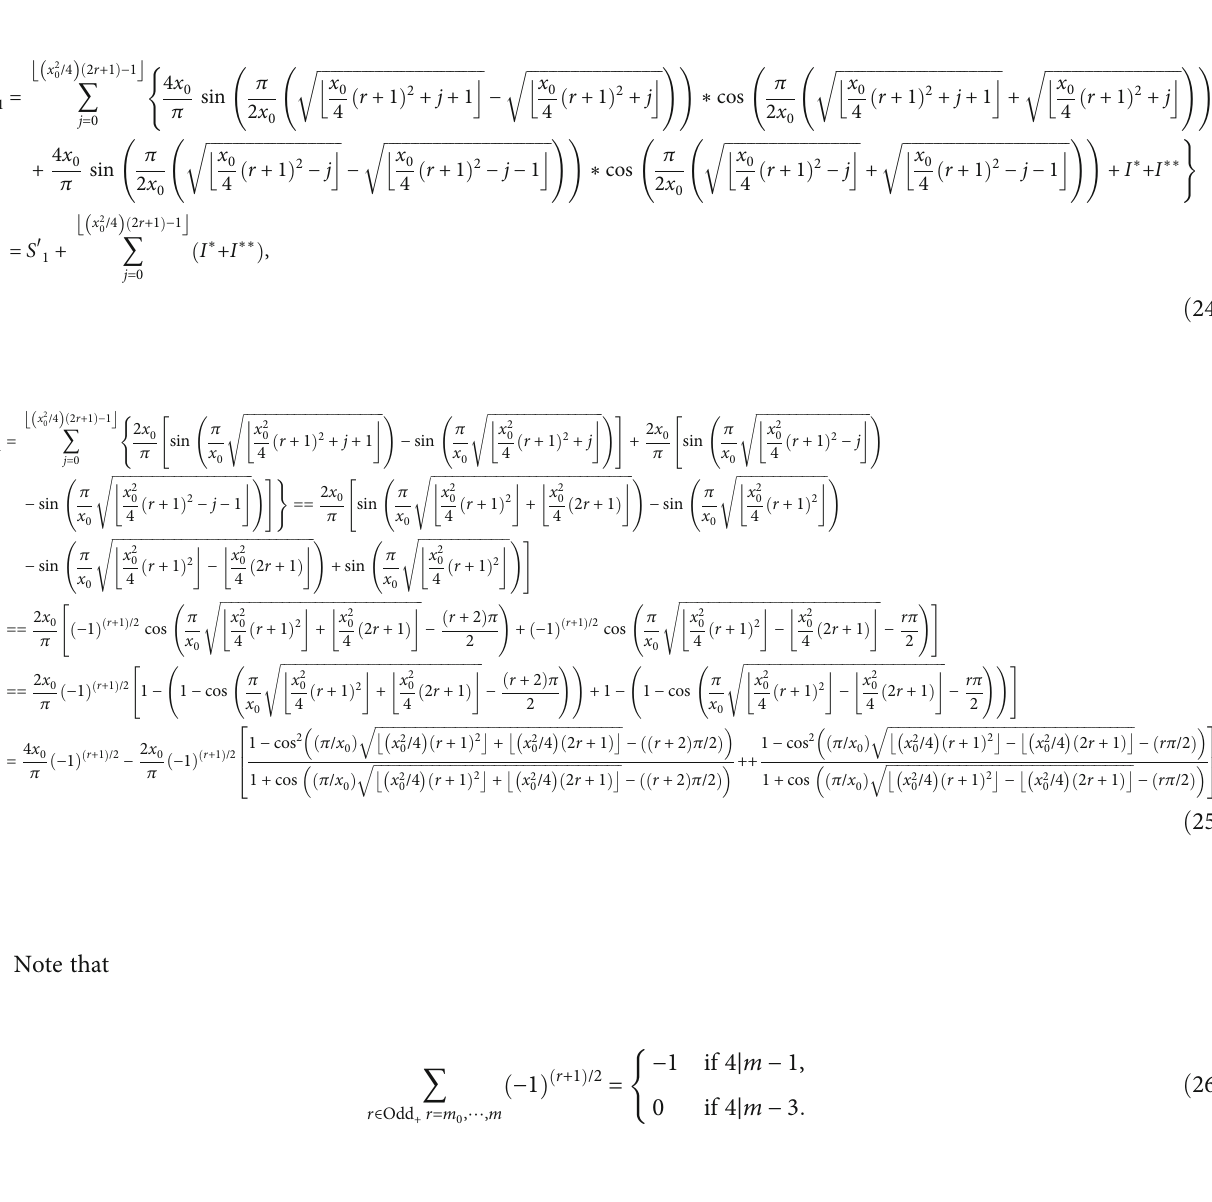
ffiffiffiffiffiffiffiffiffiffiffiffiffiffiffiffiffiffiffiffiffiffiffiffiffiffiffiffiffiffiffi x 0